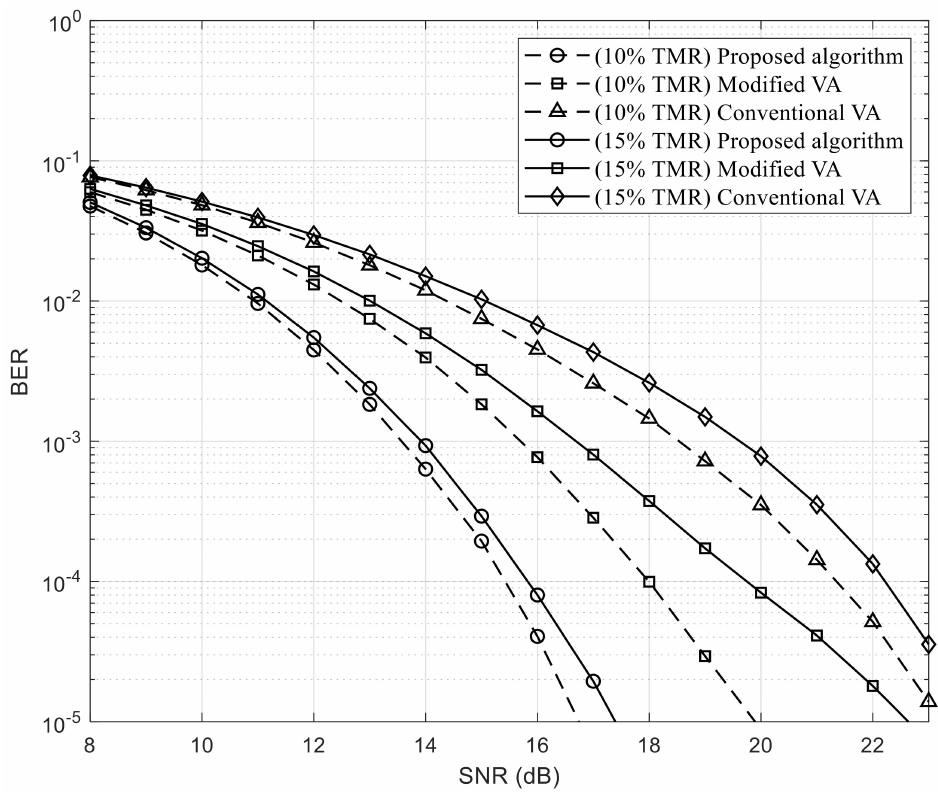
Figure 15. BER versus SNR for 10% and 15% track misregistration